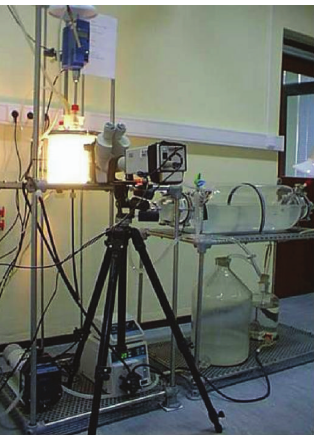
Figure 1: Experimental mixer-settler setup and image acquisition technique.